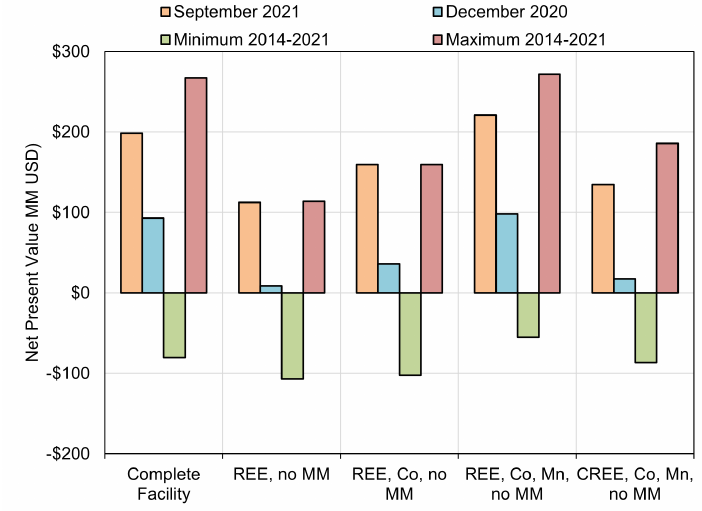
Figure 4. Net present value results for various operational configurations and pricing scenarios.